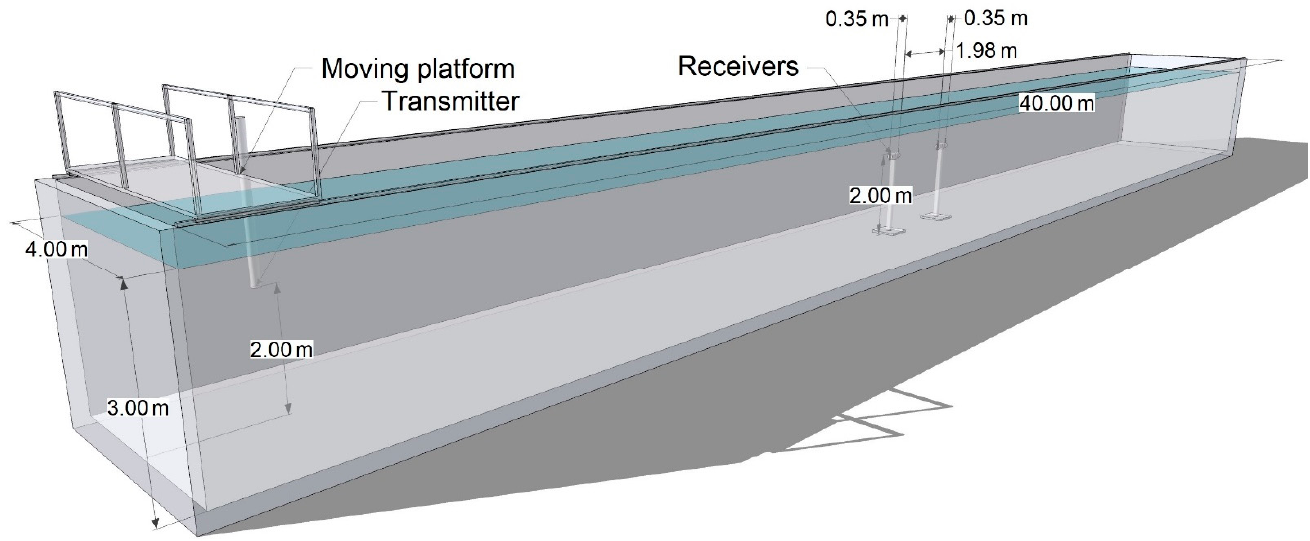
Figure 1. Deployment of the measuring devices.